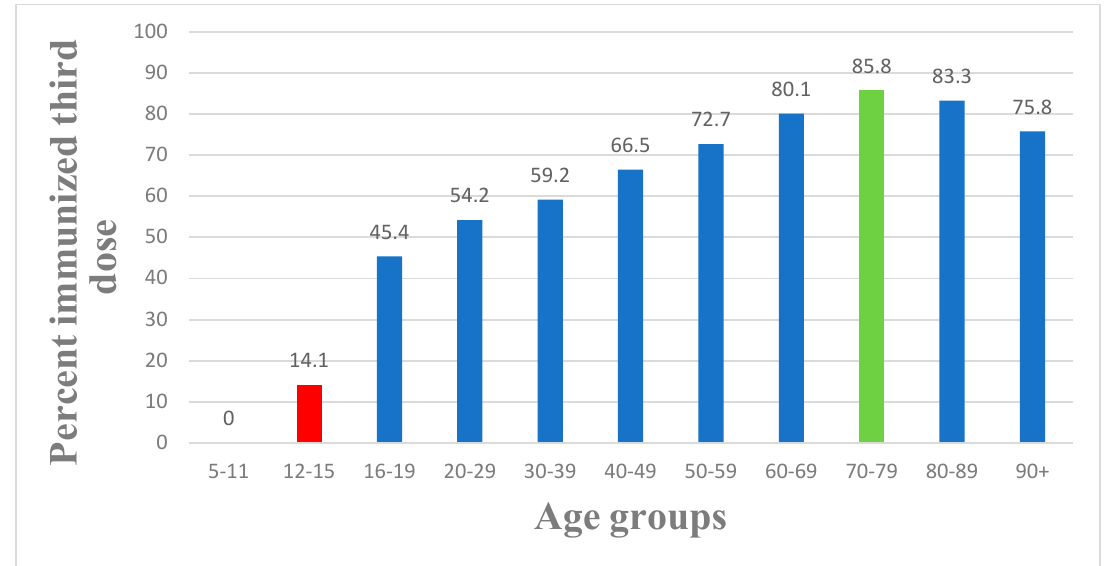
Figure 5. Percentage of people by age who had received the Pfizer booster dose.